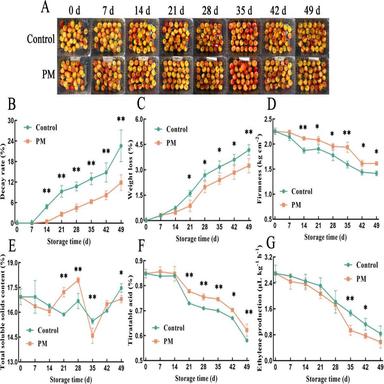
Effect of treatment of PM on the appearance of fruits (A), decay rate (B), weight loss (C), firmness (D), SSC (E), titratable acid (F), and ethylene production rate (G) of sweet cherries during storage at 0±2 ◦C from day 0–49 each value represents the mean for three replicates, and vertical bars indicates the standard deviations for each treatment (n = 3). The symbol \ represent statistical differences (p < 0.05).